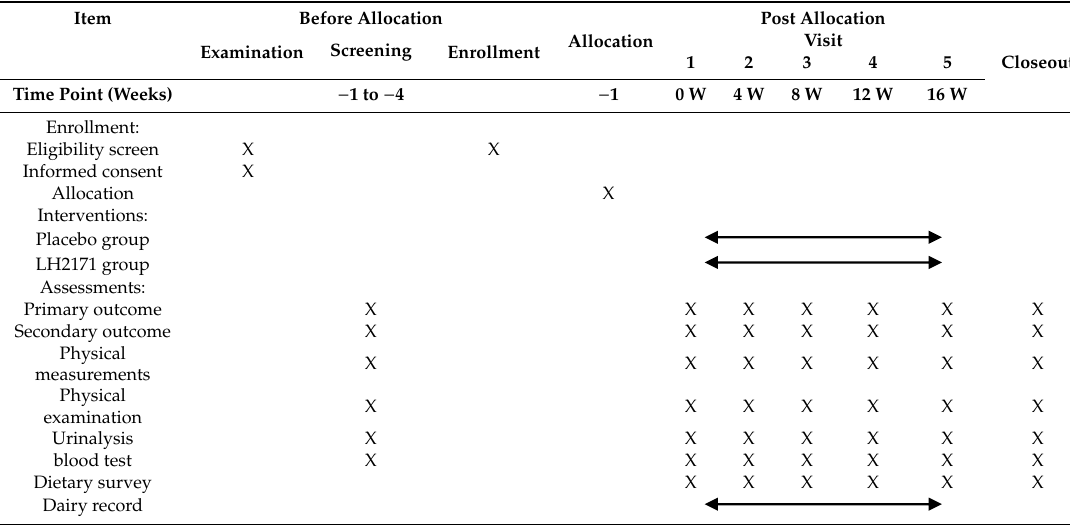
Table 1. Schedule of enrollment, intervention, and assessments.